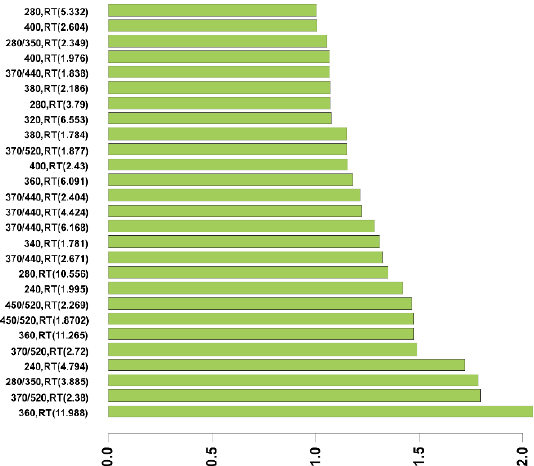
Figure 5. Characteristics of peaks for group differentiation according to the OPLS-DA model (variable importance in projection, VIP >1). The y-axis represents the peak designation (absorption, excitation/emission wavelength (nm), RT—retention time (min)).